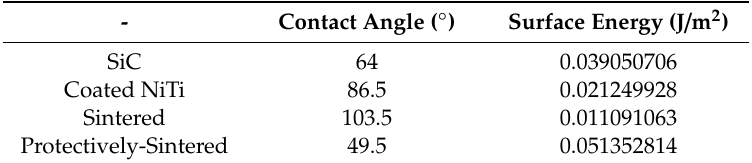
Table 2. The contact angles and the calculated surface free energy of the samples before and after sintering.